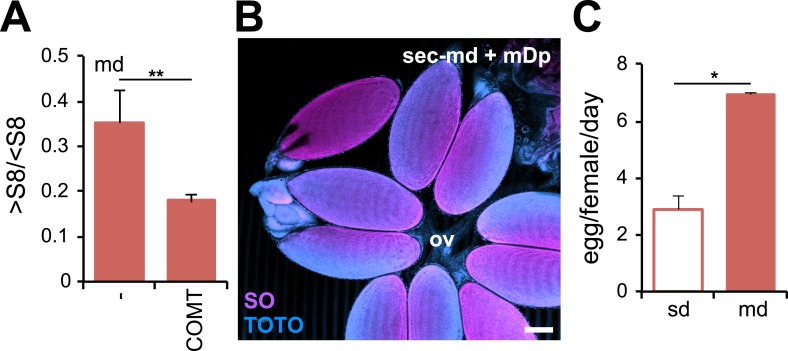
D. sechellia female fertility is modulated by morinda.(A) Rate of vitellogenesis (>S8/<S8) (N > 6) in D. sechellia (14021–0248.25) flies fed a morinda diet (md) non-pre-treated (−) or pre-treated with catechol-O-methyltransferase (2.5 U per gram of fruit, COMT). **p < 0.002 using Student's t test. Error bars represent s.e.m. (B) Confocal image shows D. sechellia (14021–0248.25, sec) egg retention in the ovary of a fly fed a morinda diet (md) supplemented with α-methyl-DOPA (0.4 mM, mDp). Dissected ovaries were stained with nucleic-acid-specific dyes (sytox orange (SO) and TOTO). The oviduct (ov) is indicated. Scale bar, 100 μm. (C) Bar graph shows ovipositon (egg/female/day) (N = 3) stimulated in D. sechellia (14021–0248.25) flies offered fresh morinda (md) as oviposition substrate compared to flies offered a standard oviposition substrate (sd). *p < 0.02 using Student's t test. Error bars represent s.e.m.